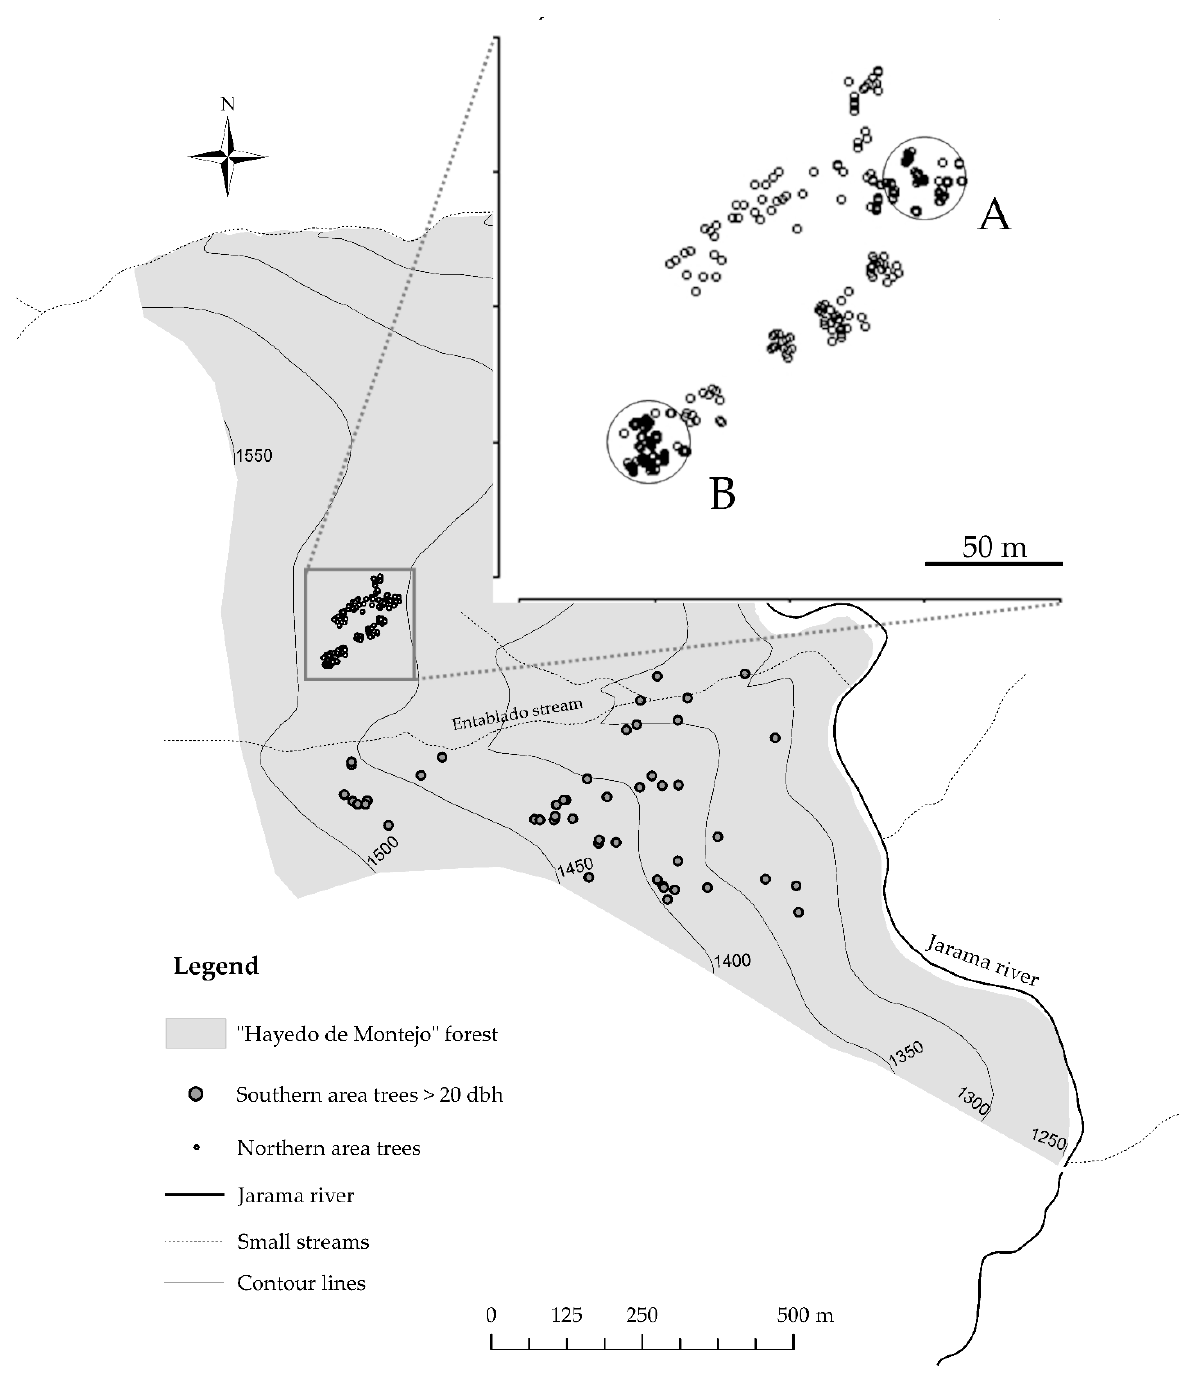
Figure 1. “Hayedo de Montejo” forest map, including the northern area with the two intensively sampled plots A and B and the connecting area between them (graph) and the southern area trees (grey and black points in the map). The contour lines are every 100 m in a range of (1250, 1550) m descending left to right. River Jarama and other smaller streams are shown.